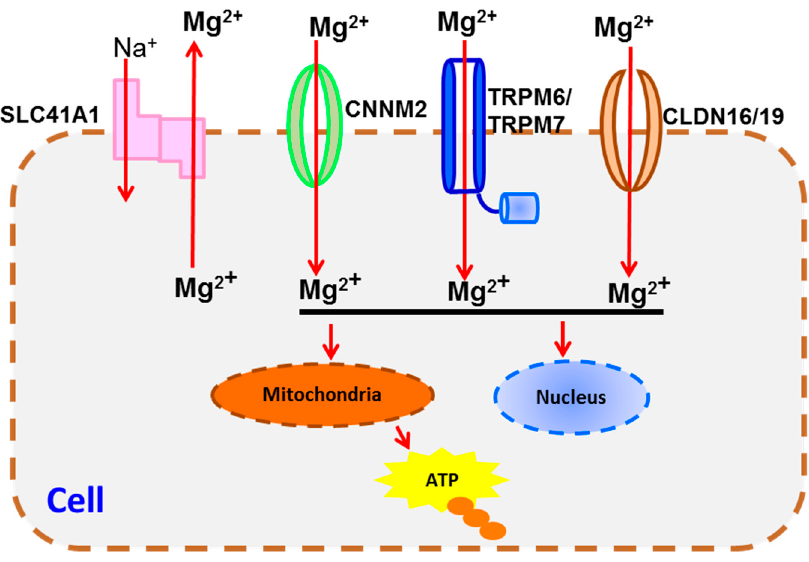
Figure 1. An illustration of the main magnesium transporters on the cell membrane.